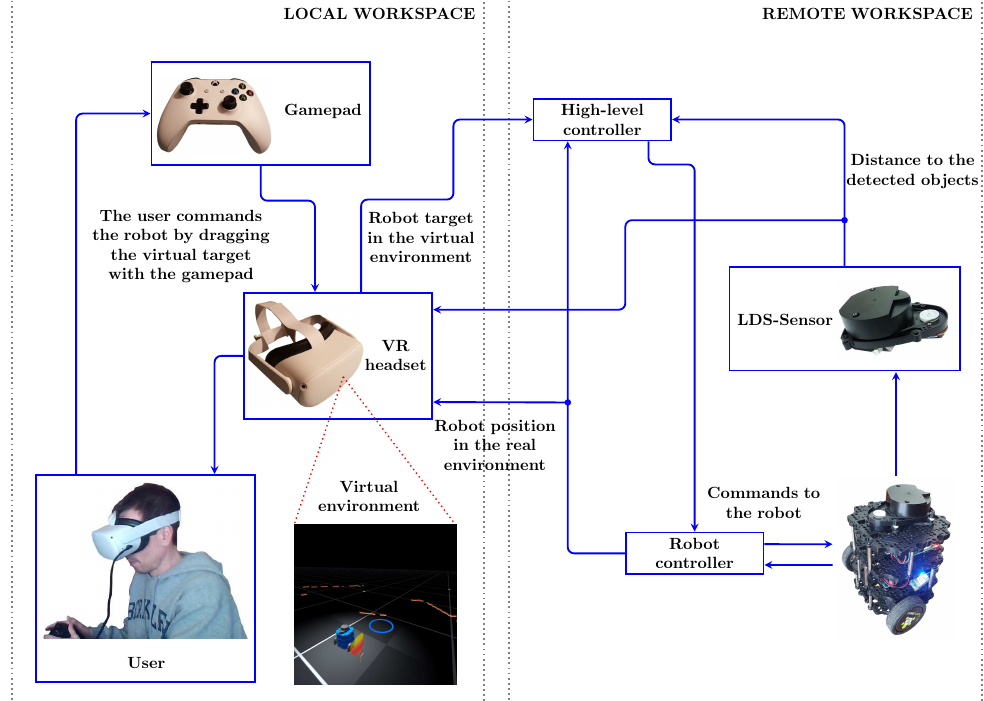
Figure 1. Remote human–robot interaction using VR with data from LDS sensor and the robot odometry.